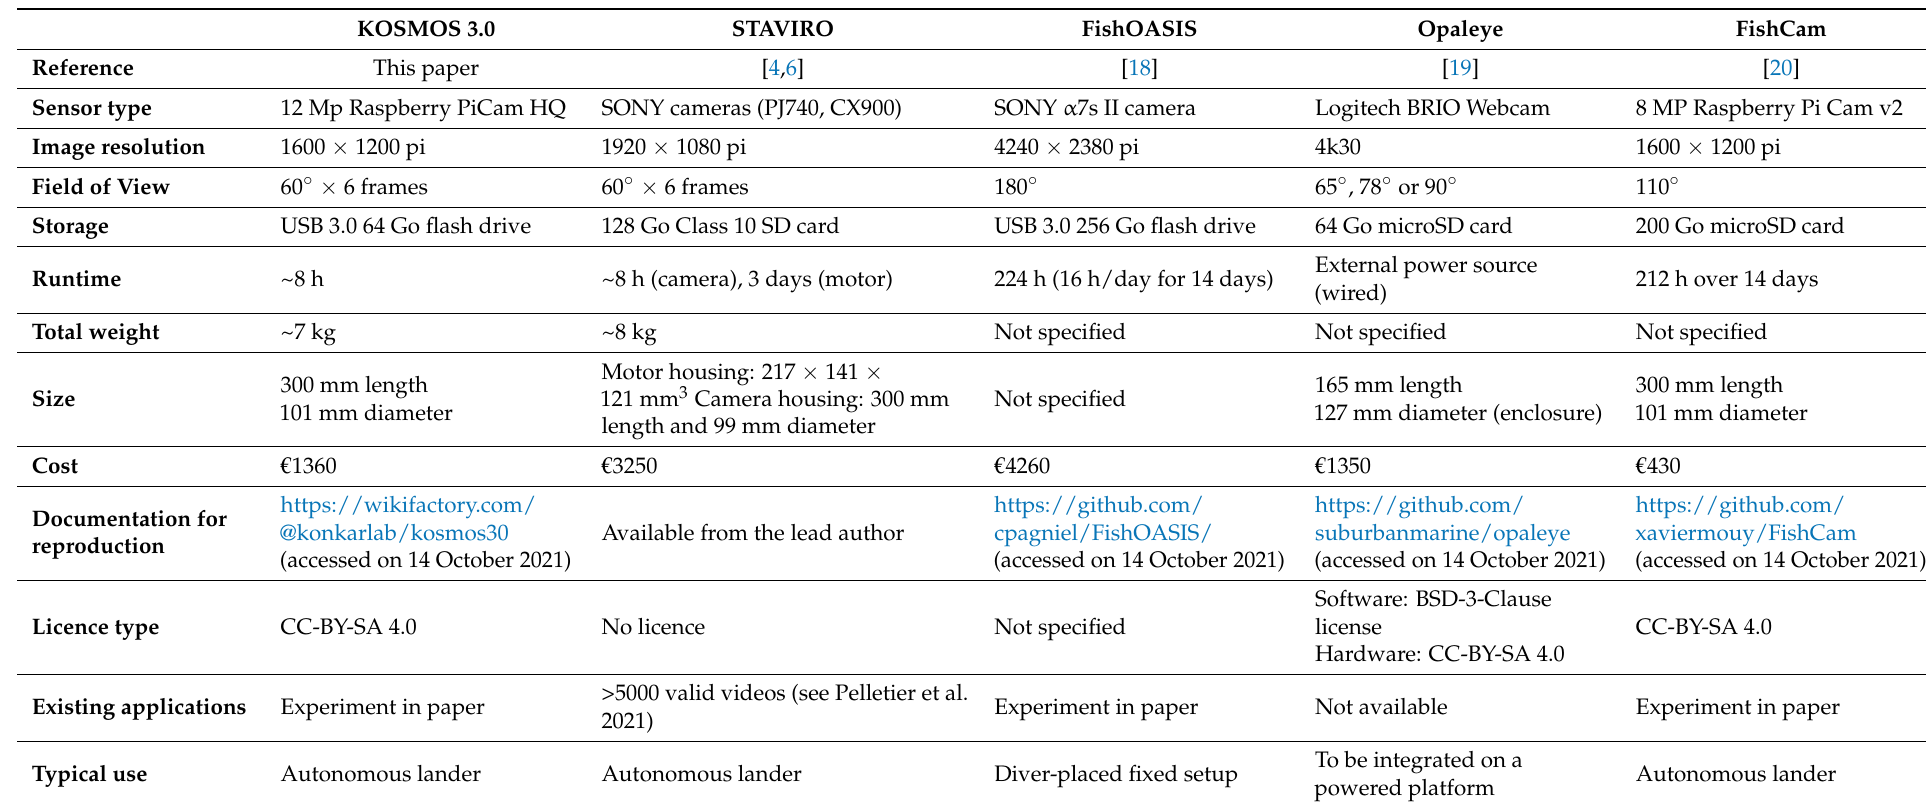
Table 2. Comparison of underwater video systems with similar uses. For KOSMOS and STAVIRO, the weight includes the tripod and 3 kg of